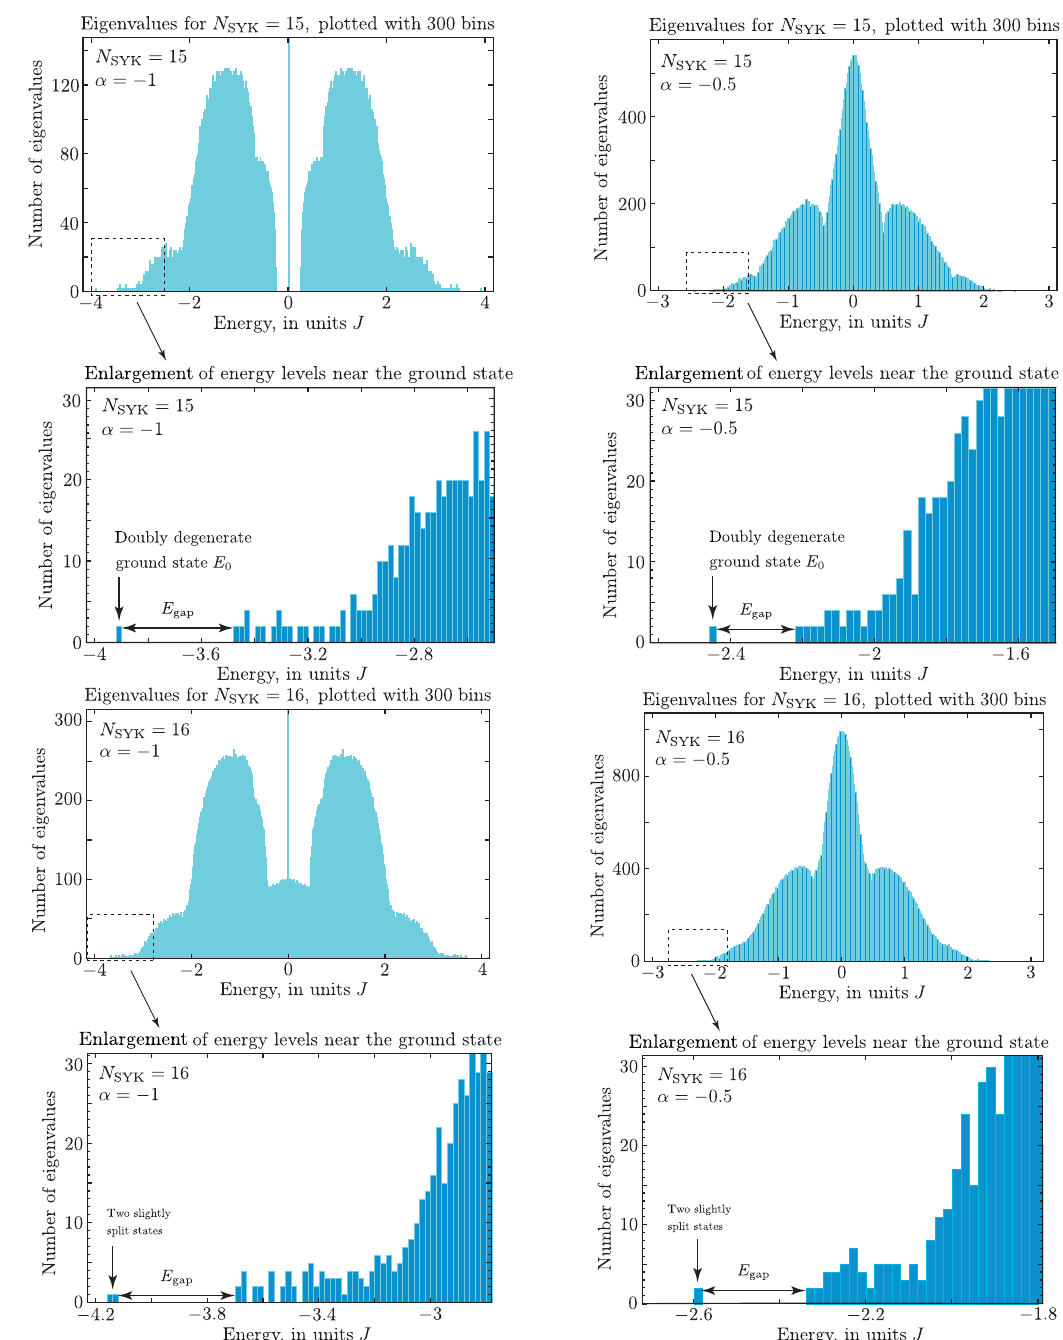
15 , 16 and α ¼ − 1 , − 0 . 5 . For α ¼ − 1 , the spectrum exhibits a gap near SYK ¼